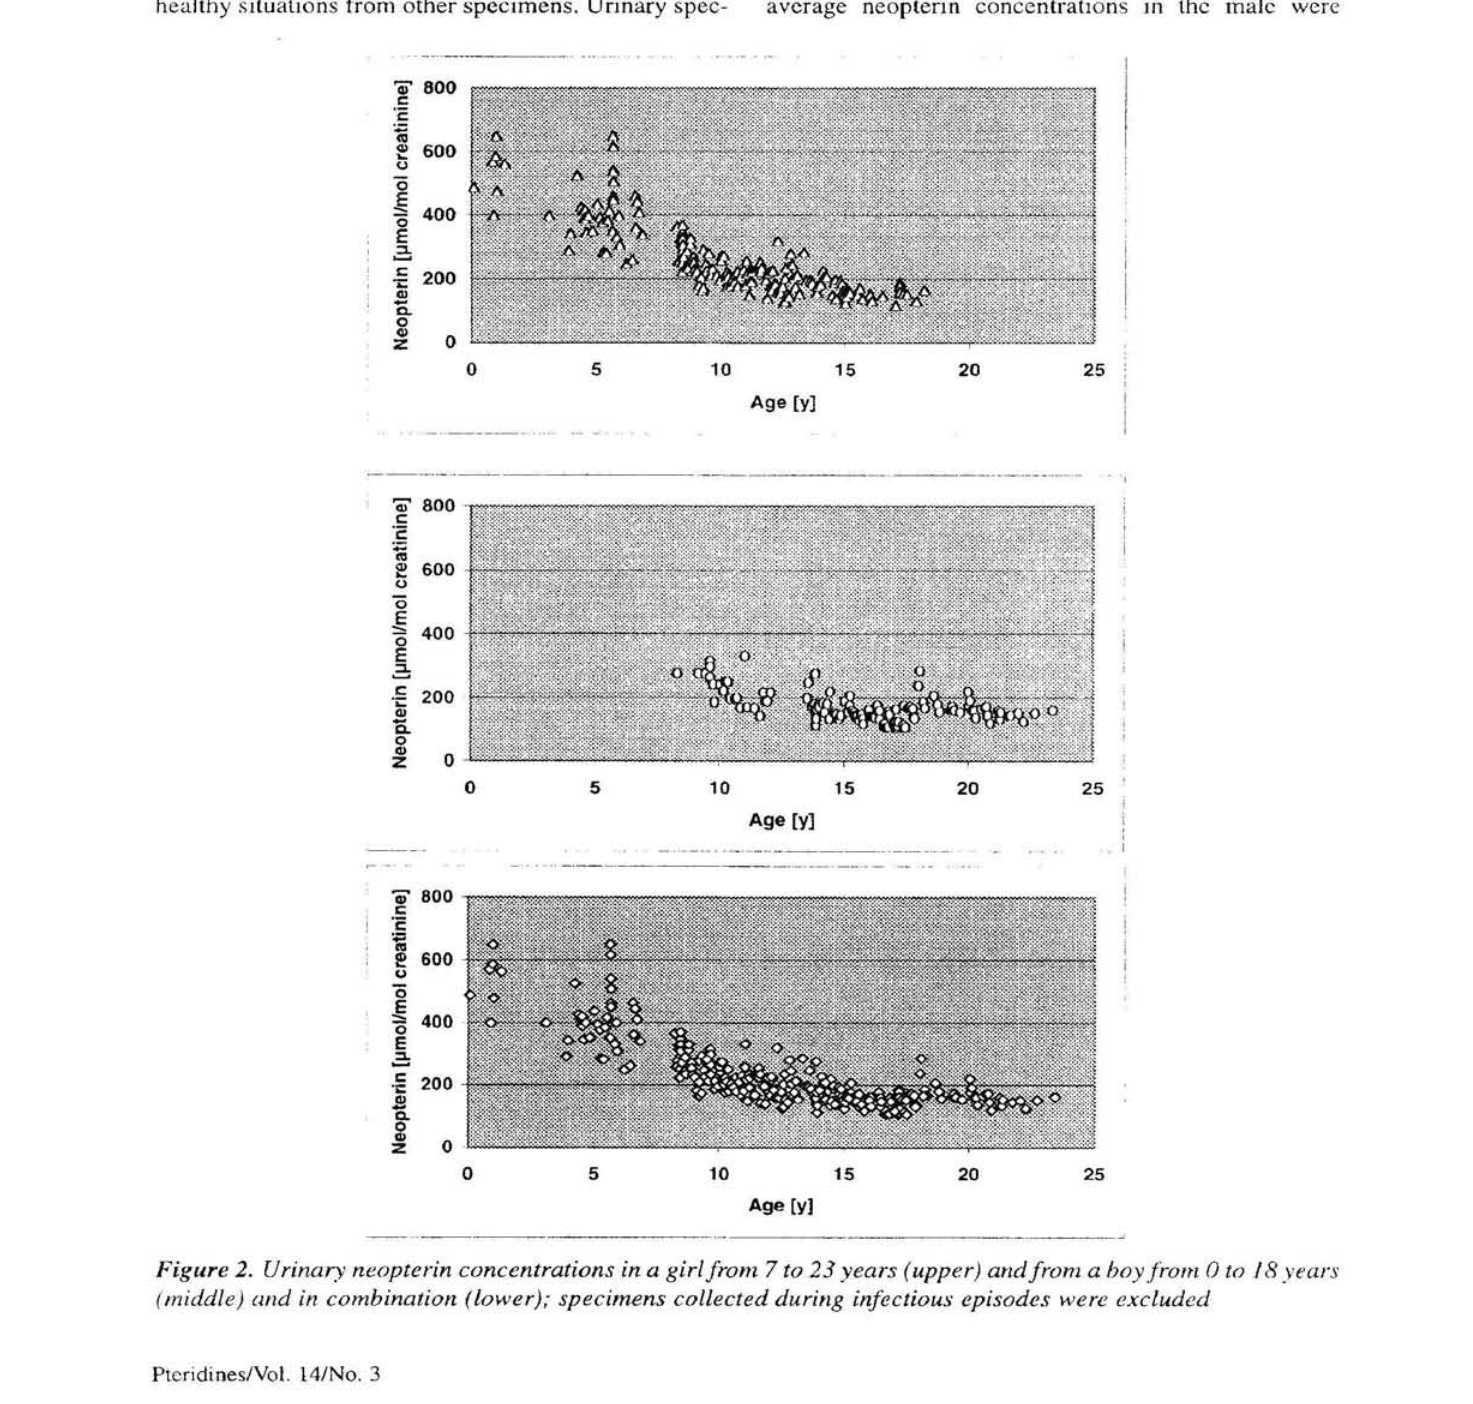
Pteridines/Vol. 14/No.